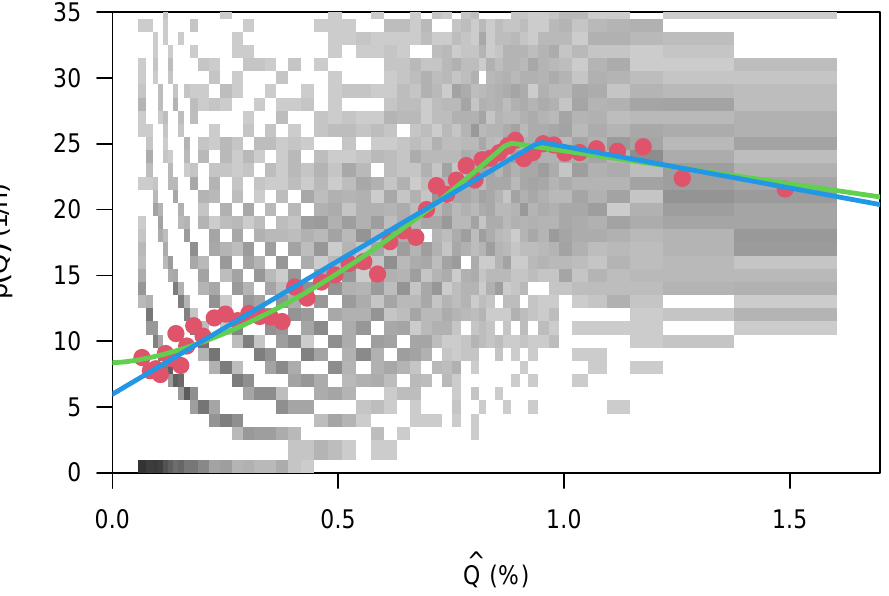
Figure 11. ρ versus ˆ Q data, together with points (red) that are the mean values of ρ computed from the data, and two different models: the green curve is from the model Equation (8), while the blue curve belongs to Equation